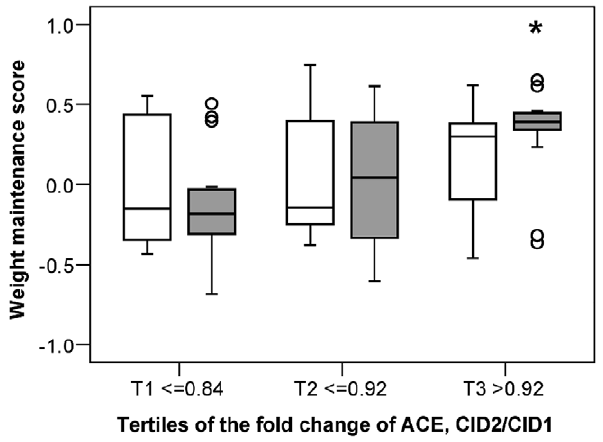
Figure 3. The relation between weight maintenance score and the fold change of ACE during weight loss. Boxplot shows the quartile range of weight maintenance score with outliers (in circle) across tertile of the fold change of ACE during weight loss, for subjects with low ( # 9.6 m mol/L, n=48, blank bar) and with high ( . 9.6 m mol/L n=47, grey bar) baseline fibrinogen level. The variation of weight maintenance score attributed to the fold change of ACE, p=0.478 in low group and p=0.014 in high group, was tested by one-way ANOVA controlled for age and the fold change of weight, and Bonferroni test for multiple comparisons. *T3 significantly different from T1 in high fibrinogen group, p=0.013.